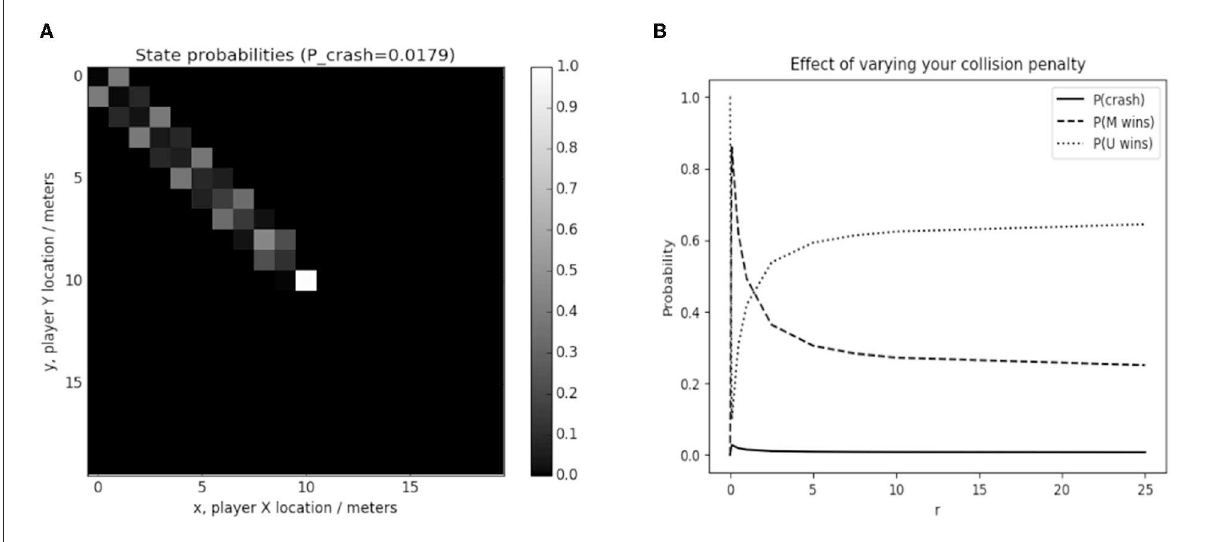
FIGURE5 (A) State probability under optimal strategies, starting from x = y = 10. (B) Effect of relative strength of agents on which one yields in optimal